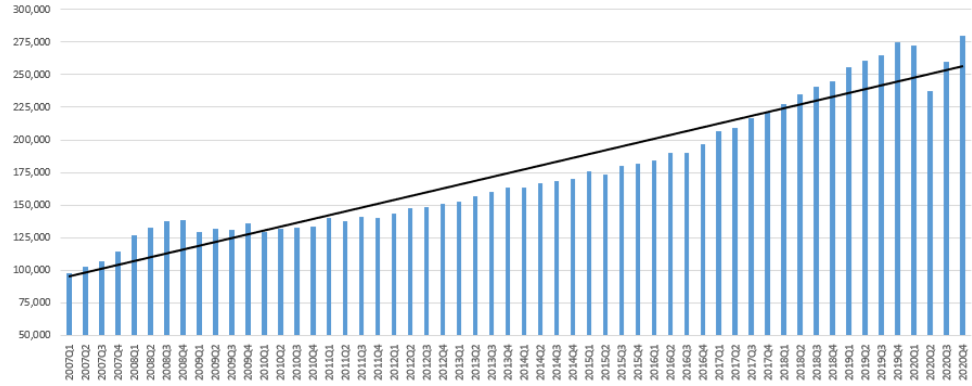
Figure 1. Evolution of GDP during the period 2007–2020.